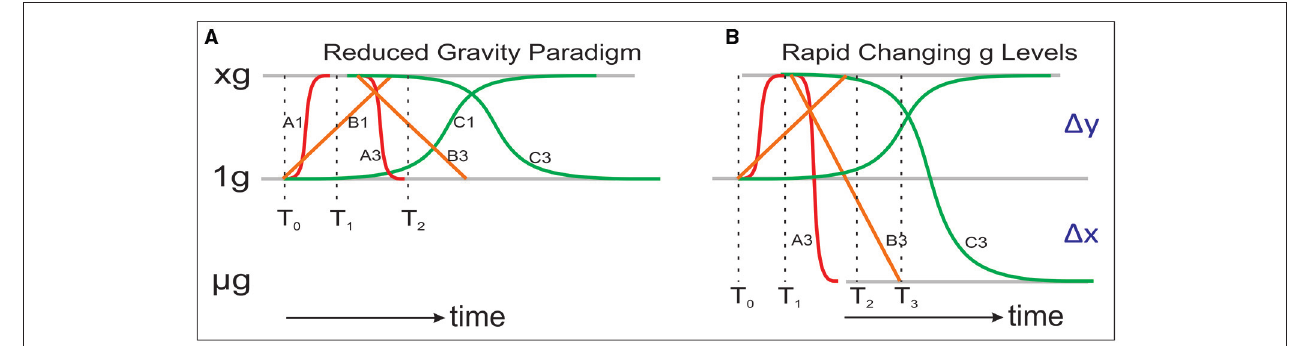
FIGURE 5 | This is a cartoon illustrating in more detail the (A) Reduced Gravity Paradigm (RGP) or (B) a real free fall experiment with rapidly changing g levels (e.g., a parabolic flight experiment). Fast responding systems (red line, A1–A3), linearly somewhat intermediate responding systems (orange line, B1–B3) and slow responding systems (green line,